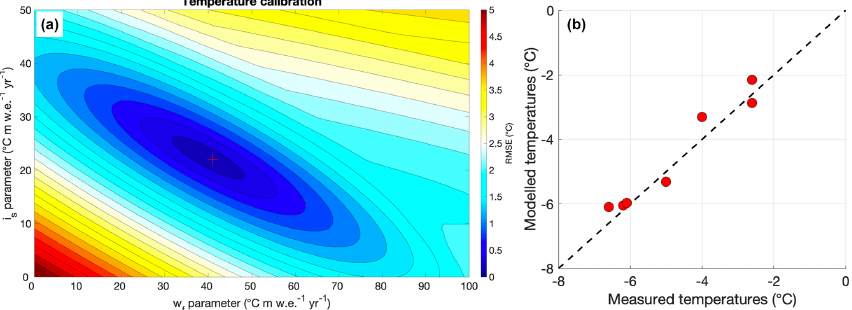
Figure 5. (a) Calibration of the w f and the i s parameters based on ice temperature measurements of the Grigoriev ice cap. (b) Modelled and measured temperatures for different elevations and times of the Grigoriev ice cap.